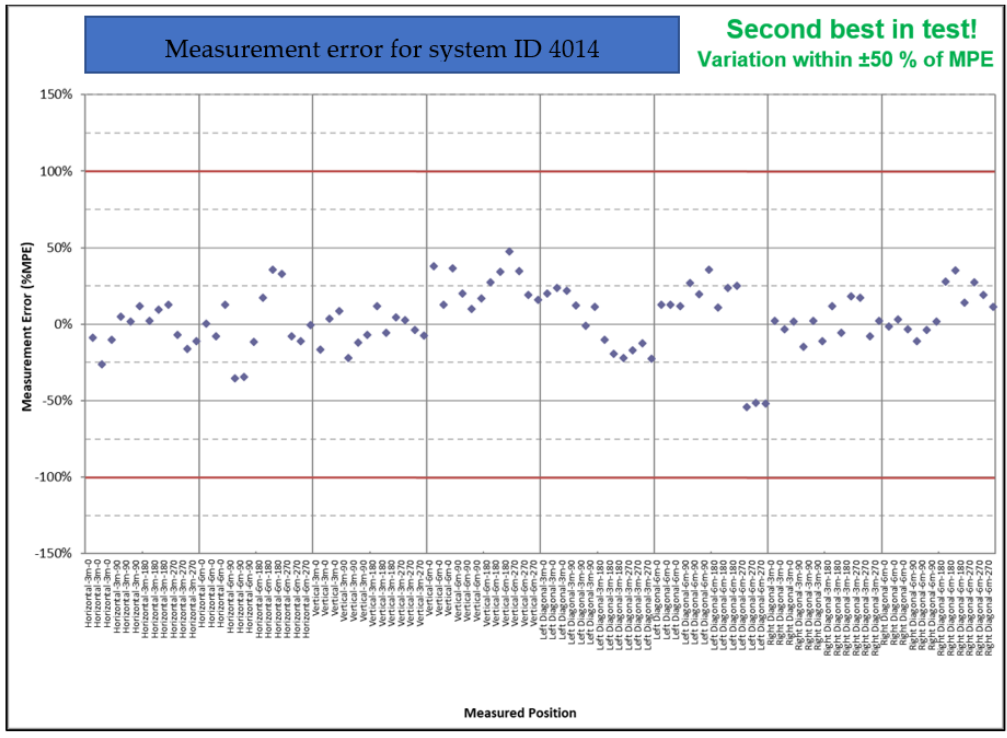
Figure 9. The first verification and calibration performance test and results, Nikon APDIS MV430E Laser Radar, sensor unit ID 4014. The control chart displays measured position of the scalebar as a function of the percentage of the Maximal Permissible Error (%MPE).